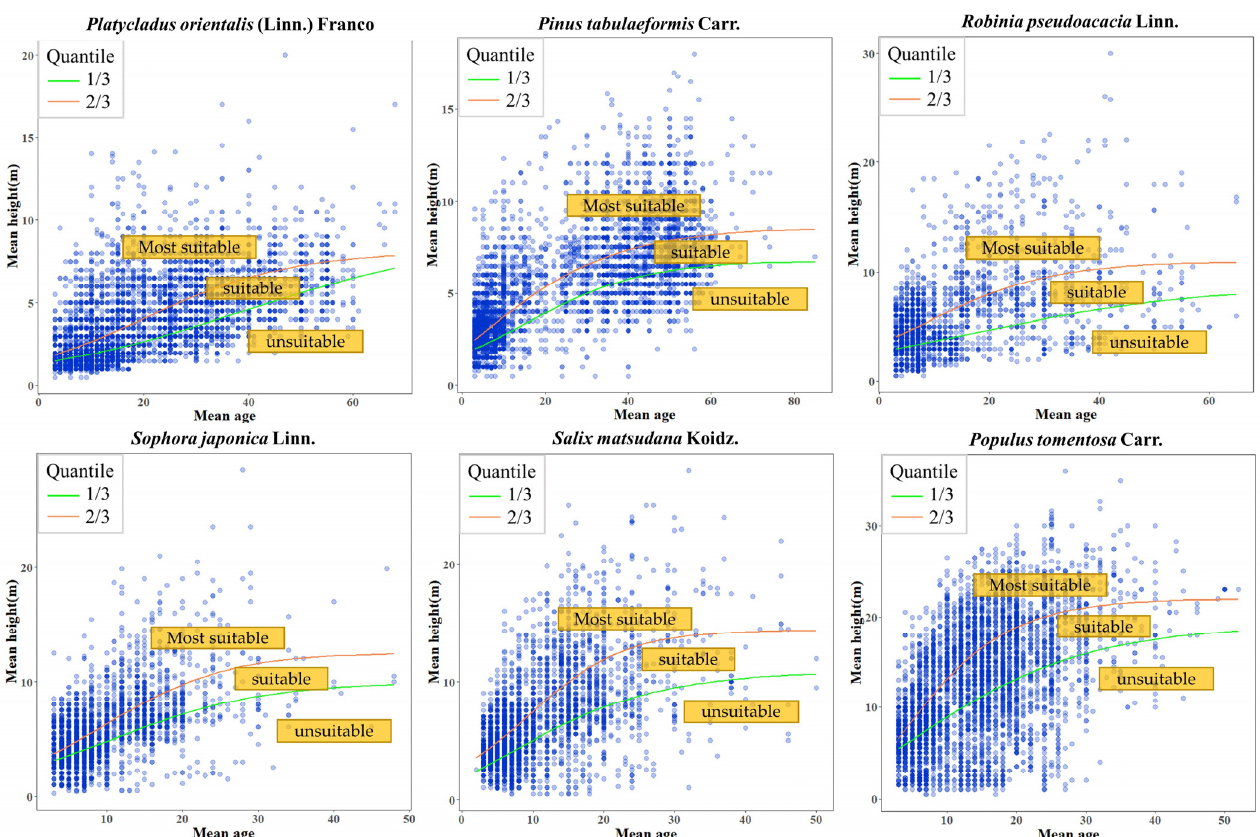
Figure 3. Distribution of stand site tree suitability for 6 main tree species.